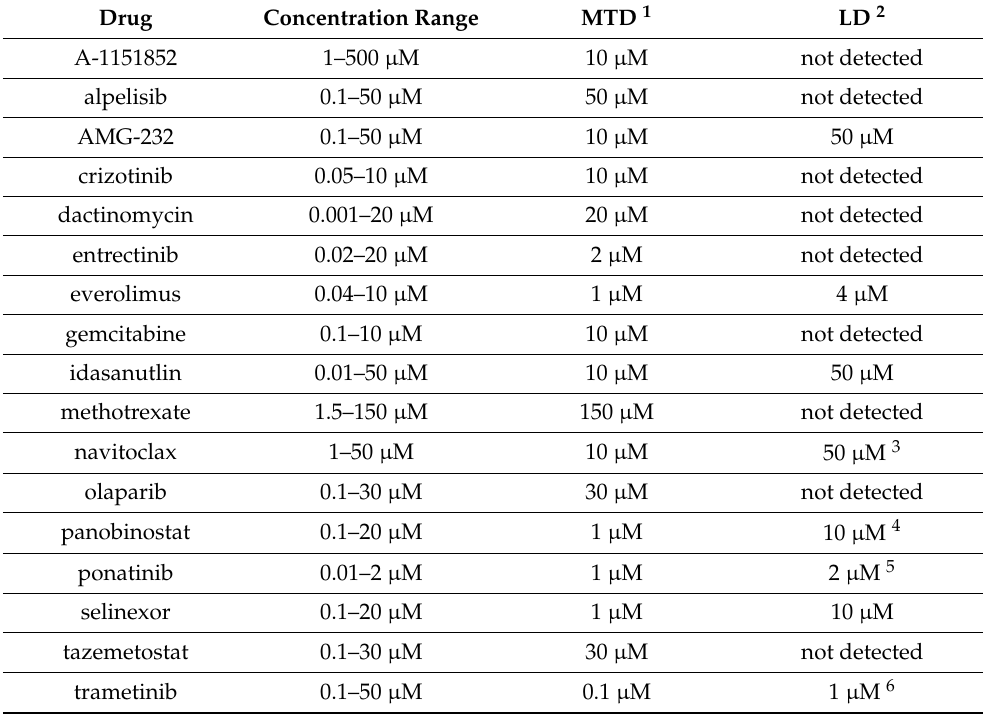
Table 5. Zebrafish Embryo Toxicity